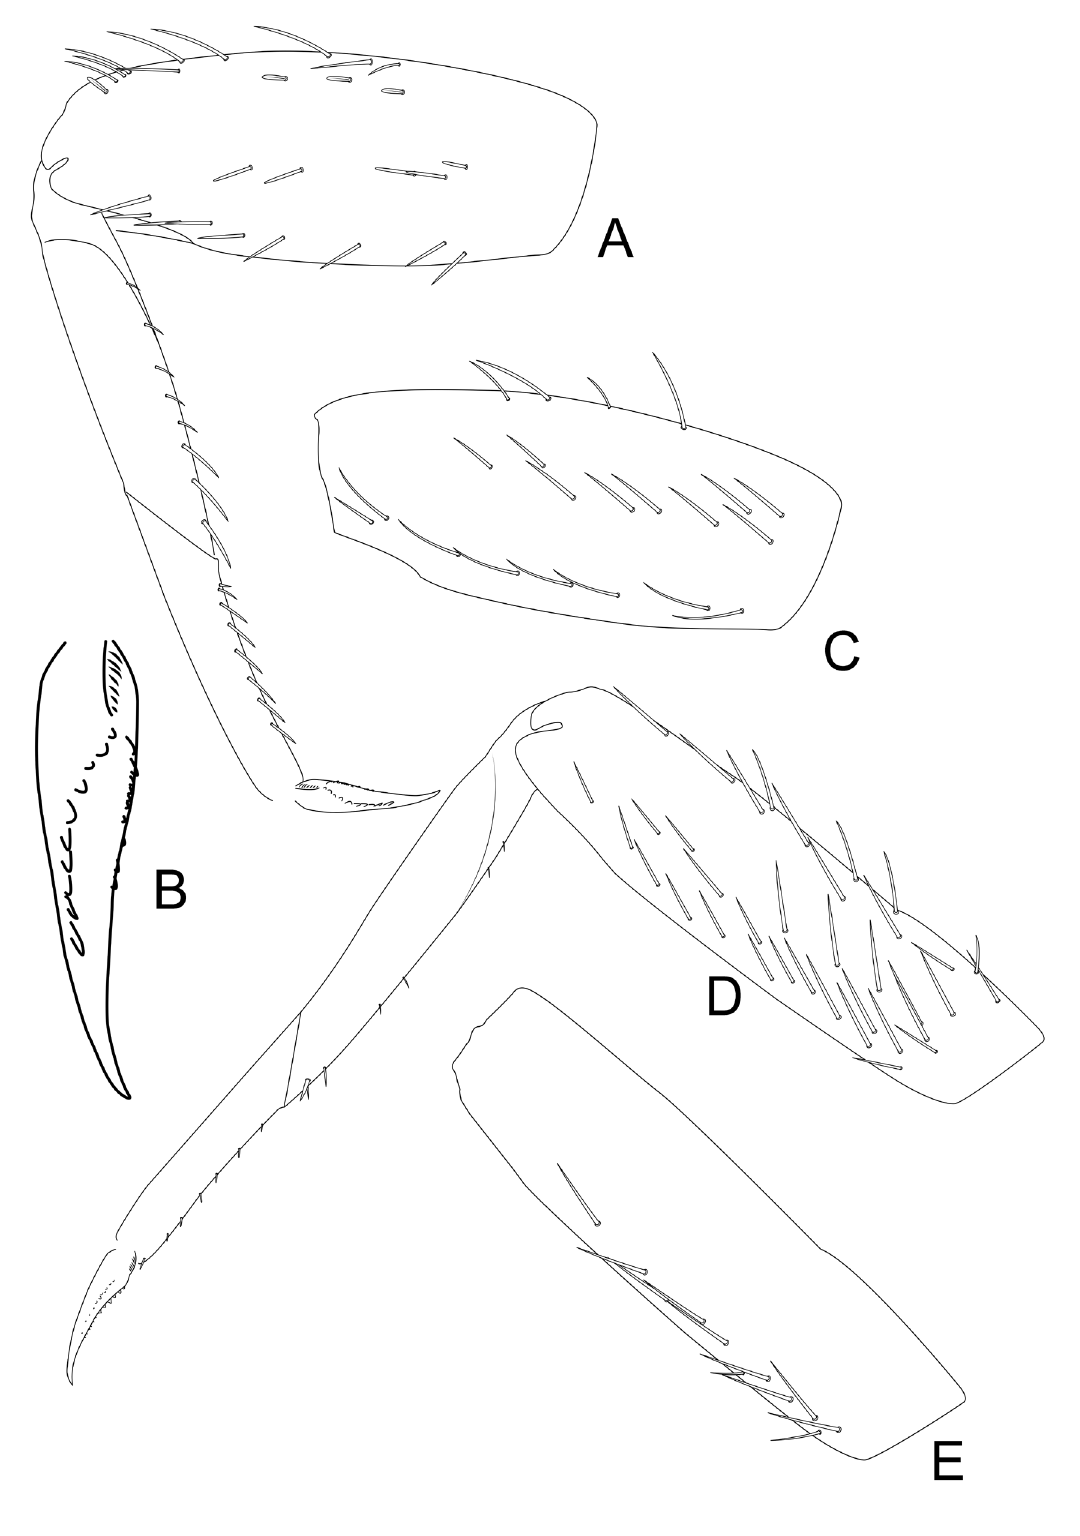
Fig. 5. Rivudiva amazona sp. nov., holotype (INPA). A . Foreleg (femur on anterior surface). B . Detail of fore claw. C . Posterior surface of forefemur. D . Hind leg (femur on anterior surface). E . Posterior surface of hind femur. Not to